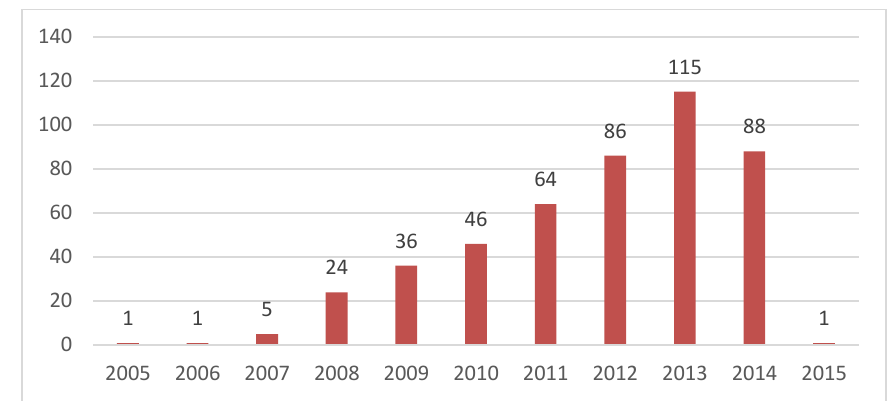
Figure 2. Number of citations per